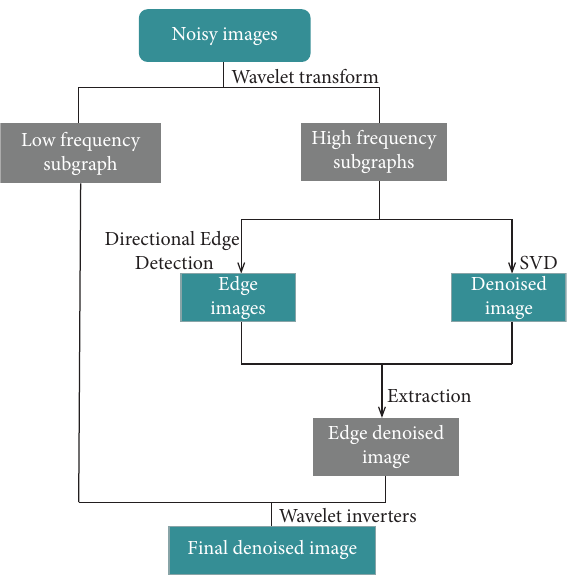
Figure 5: Image denoising algorithm